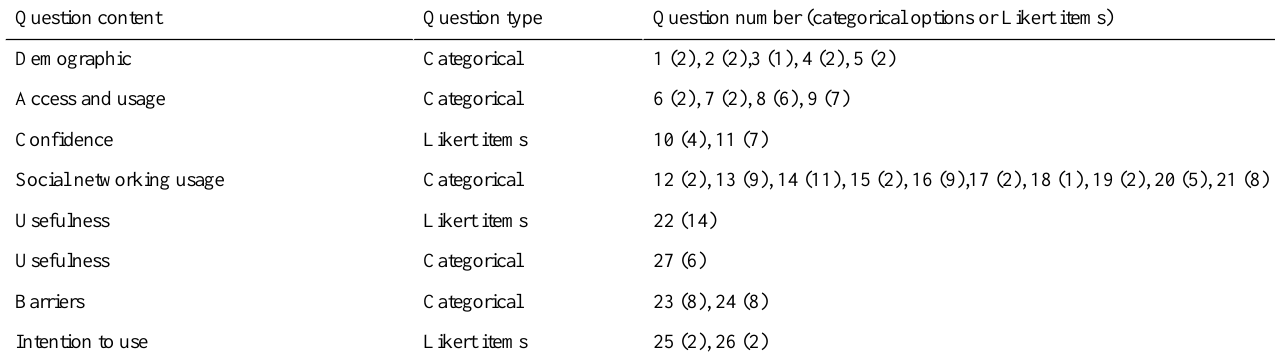
Table 1. Survey content and question